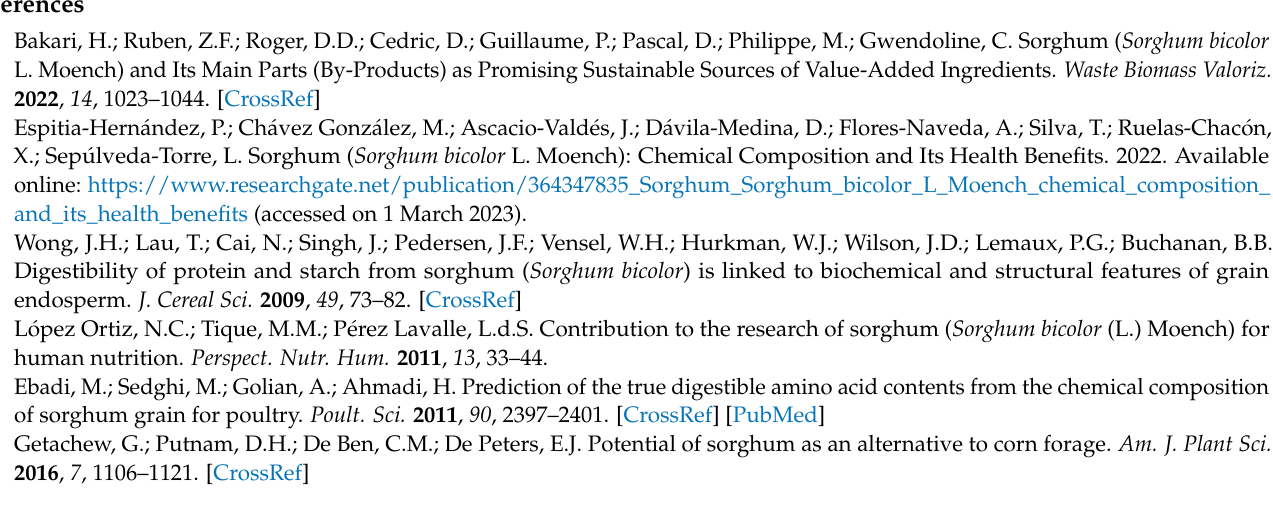
Figure S2: Number of mutant lines with various concentrations of non- protein amino acids such as taurine, lanthionine, and ornithine